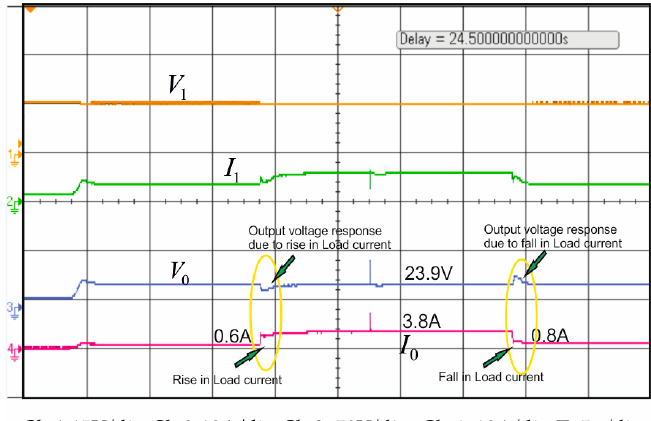
Figure 17. Voltages and currents from the experiment during transient condition. Input voltage, input current, load voltage and current (CH 1–4).